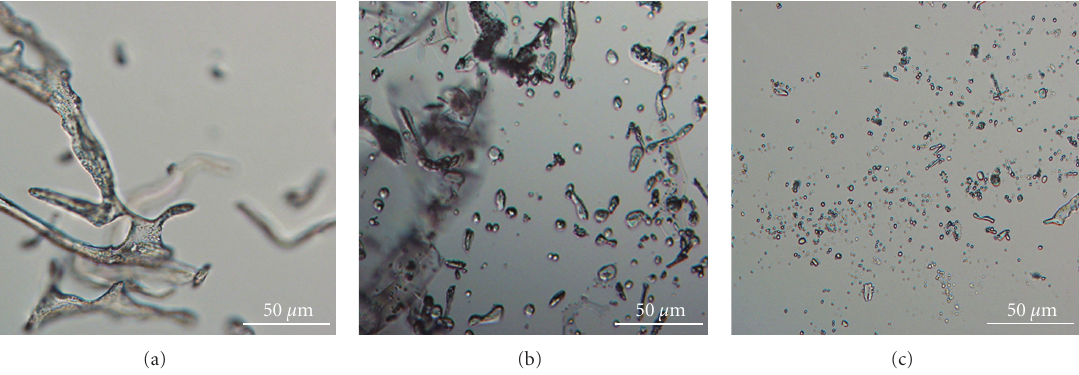
Figure 1: Morphology of obtained polymers; the light microscopy images: (a) pNIPAM-A, (b) pNIPAM-B, (c) pNIPAM-C.